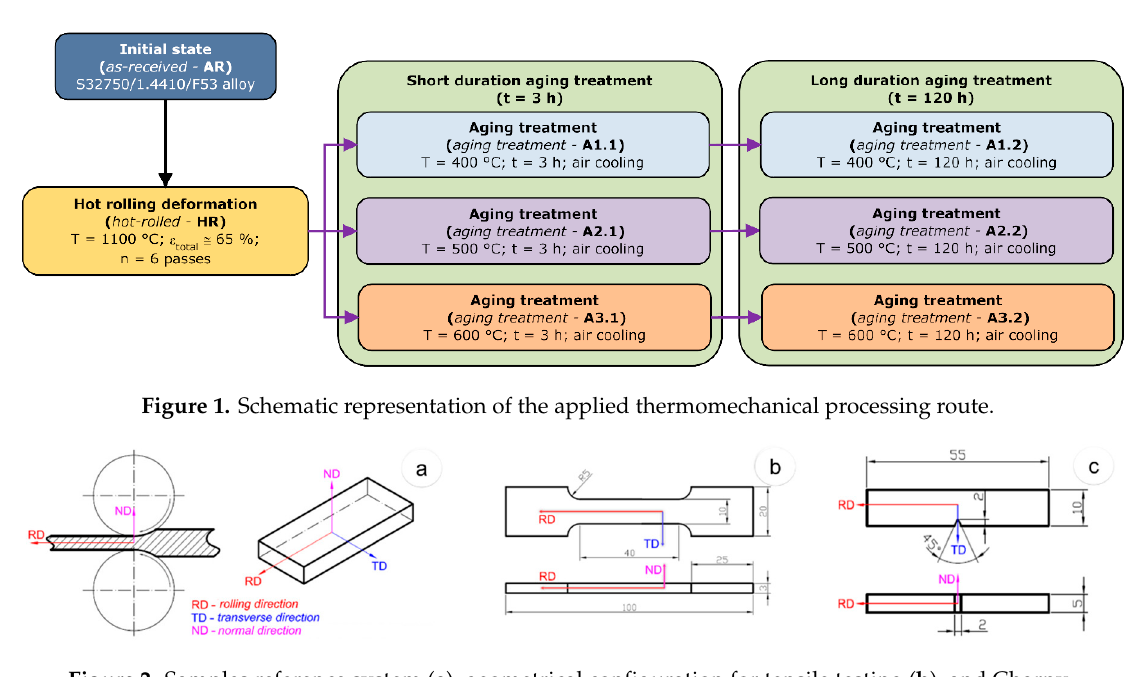
Figure 2. Samples reference system ( a ), geometrical configuration for tensile testing ( b ), and Charpy testing specimens ( c ).